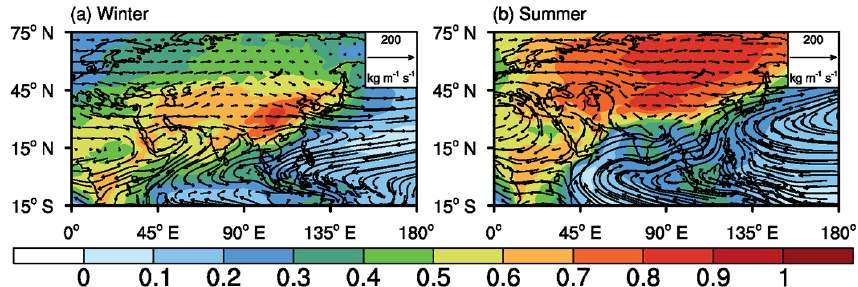
Figure 3. Distribution of the relative contribution to precipitation from all land source regions defined in Fig. 1 (colours; unit: ratio of tagged precipitation over total precipitation) and the vertically integrated total tropospheric water vapour flux (arrow streamlines; unit: kgm − 1 s − 1 ) during (a) winter and (b) summer.